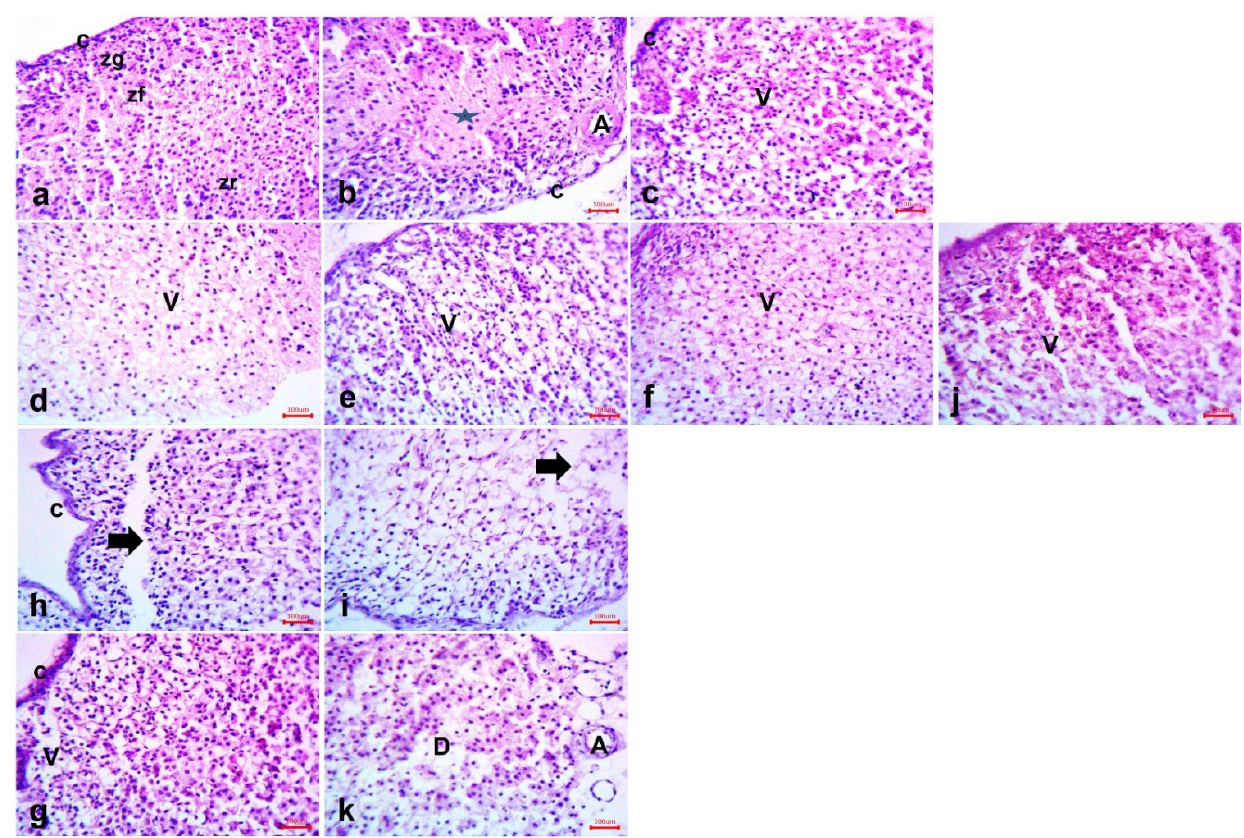
Figure 11. Photomicrographs of the supra renal tissue of ( a ) Sham group showing adrenal gland covered by a connective tissue capsule ( C ). Beneath the capsule, the cells of the zona glomerulosa (Zg) are seen. The next wider zone is the zona fasciculata (ZF) with a regular arrangement of its cells and the zona reticularis (zr). ( b ) Model group showing distorted zones with degeneration (star) with a dilated artery ( A ). ( c ) Reference group showing amelioration of all zones, but vacuolations could be seen in most sections (V). ( d − j ) groups 1, 3, 5, and 6 showing apparent normal supra renal tissue, but vacuolations can still be seen ( V ). Few dark, dense nucleoli (arrows) could be detected (arrow). ( h , i ) Drug 4 and 7 showing moderate thicken capsule (c) with some areas appear with tissue lost (arrows). Notice the more observable apoptotic cells (arrows). ( g , k ) Groups 2 and 8 showing severe damage to the suprarenal tissue (D). Notice the thicken capsule (c) and the dilated blood (a). Notice the more notable apoptotic cells (arrows). H & E, × 400.